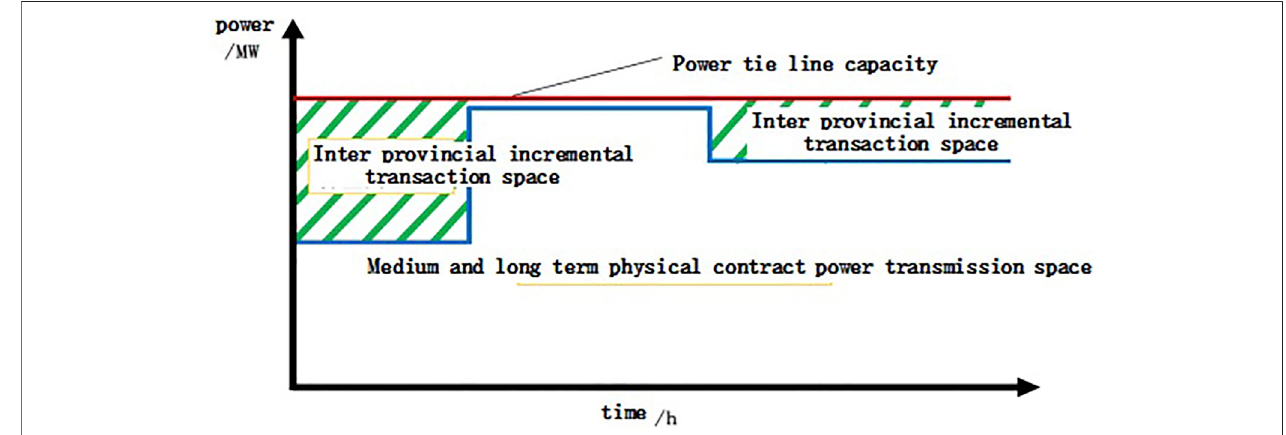
FIGURE 3 | Schematic diagram of interprovincial consumption under the mode of interprovincial incremental spot